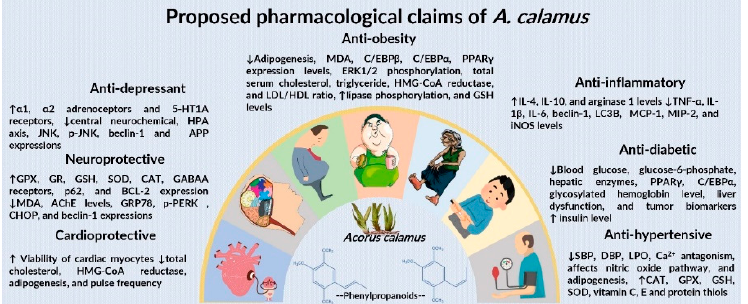
Figure 6. Illustration of role of A. calamus mechanisms in the treatment of neurological and metabolic disorders. AChE, acetylcholinesterase; APP, amyloid precursor protein; Bcl-2, B-cell lymphoma 2; CHOP, C/EBP homologous protein; CCAAT (cytosine-cytosine-adenosine-adenosine-thymidine)- enhancer-binding protein homologous protein; C/EBP, CCAAT enhancer-binding protein; GABAA, γ -Aminobutyric acid type A; GRP78, 78-kDa glucose-regulated protein; HMG-CoA, 3-hydroxy-3-methylglutaryl coenzyme A; iNOS, inducible nitric oxide synthase; JNK, c-Jun NH2-terminal kinase; LC3b, microtubule-associated proteins 1A/1B light chain 3B; MCP, modified citrus pectin; MDA, malondialdehyde; MIP, macrophage inflammatory protein; p-PERK, phospho-protein kinase RNA-like ER kinase; PPAR γ , peroxisome proliferator-activated receptor gamma; ERK1/2, extracellular signal-regulated protein kinase.